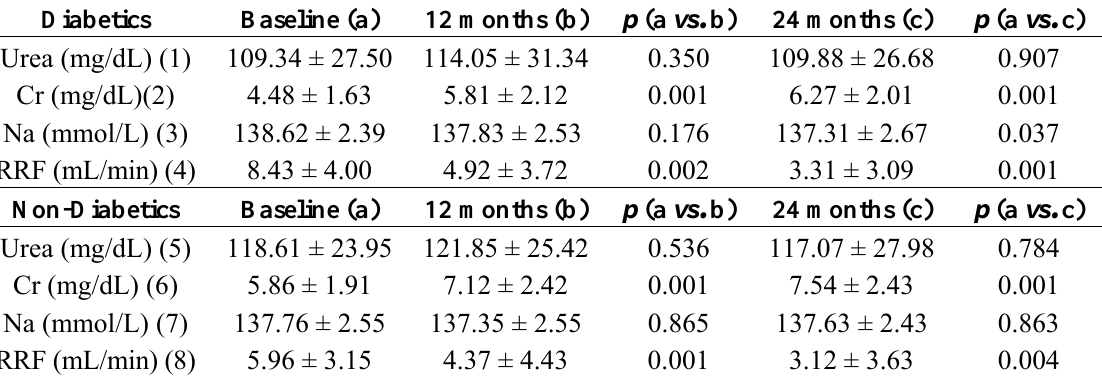
Table 3. Serum biochemical parameters and Residual Renal Function